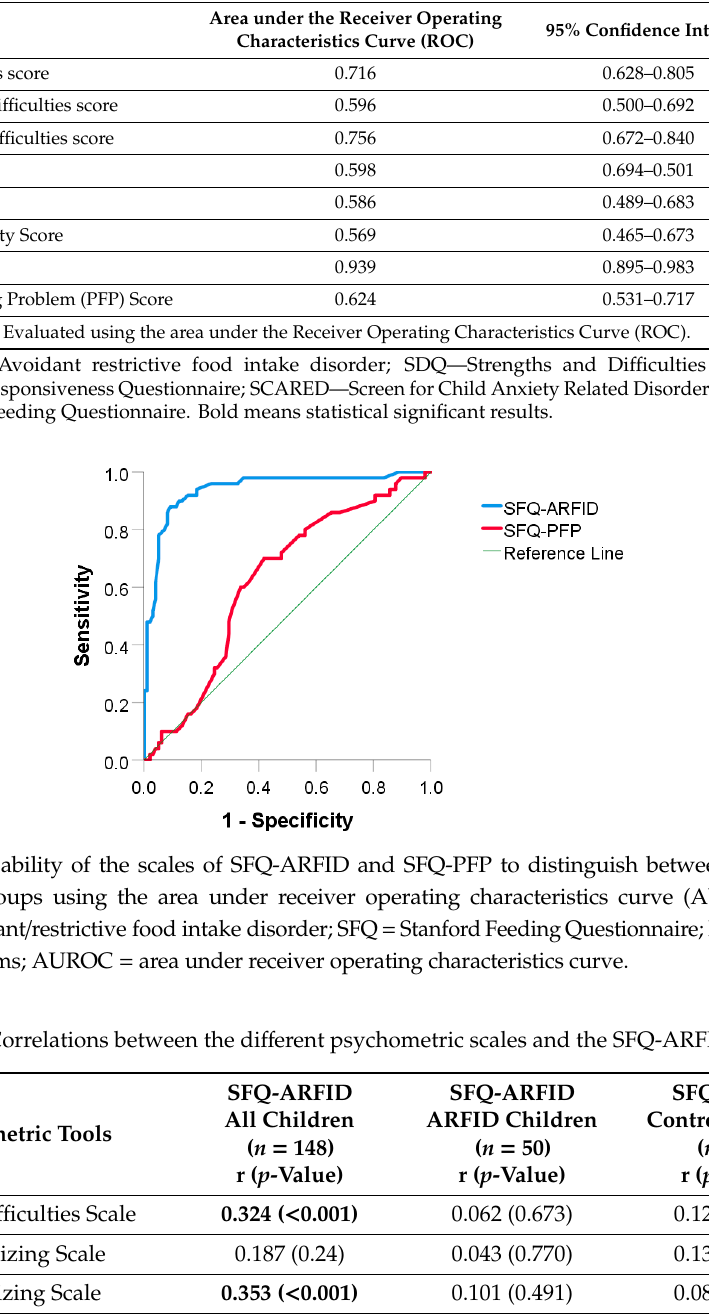
Table 4. ThepotentialoftheparentreportstodifferentiatebetweenchildrenwithARFIDandcontrolchildren.